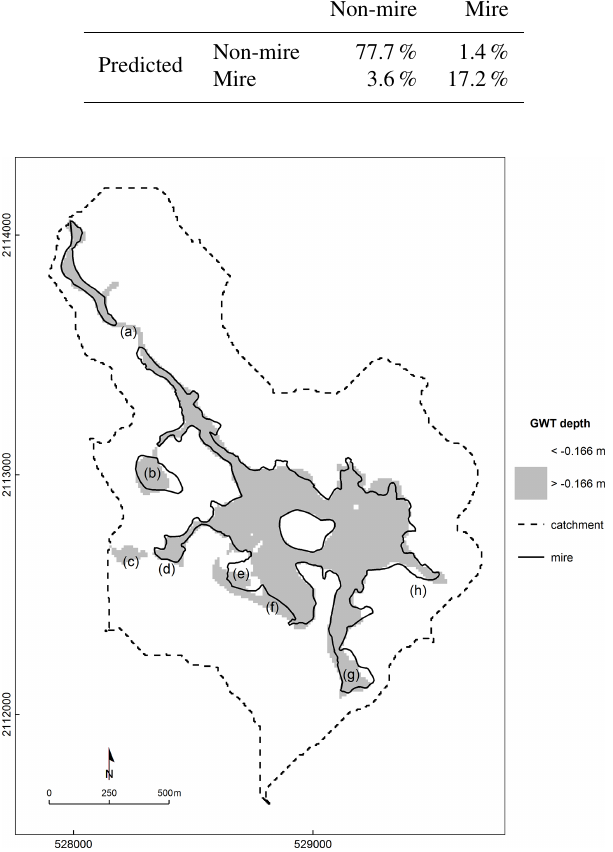
Figure 7. Observed mire boundary based on botanical (Durepaire and Guerbaa, 2008) and pedological (Duranel, 2015) criteria and the predicted mire distribution based on model results (simulated 2001–2013 mean groundwater table depth higher than 0.166m be- low ground level). (a–h) refer to locations discussed in the text (see Sect.